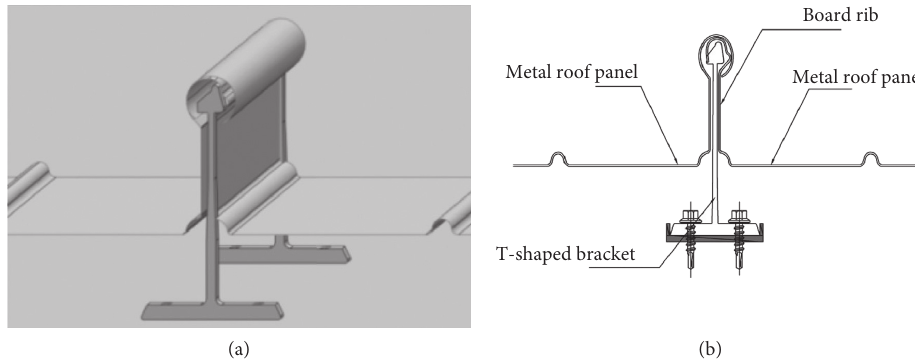
Figure 3: The structure of metal roof enclosure system. (a) The structure of standing seam metal roof. (b) The panel is fixed on the purlins with T -shaped